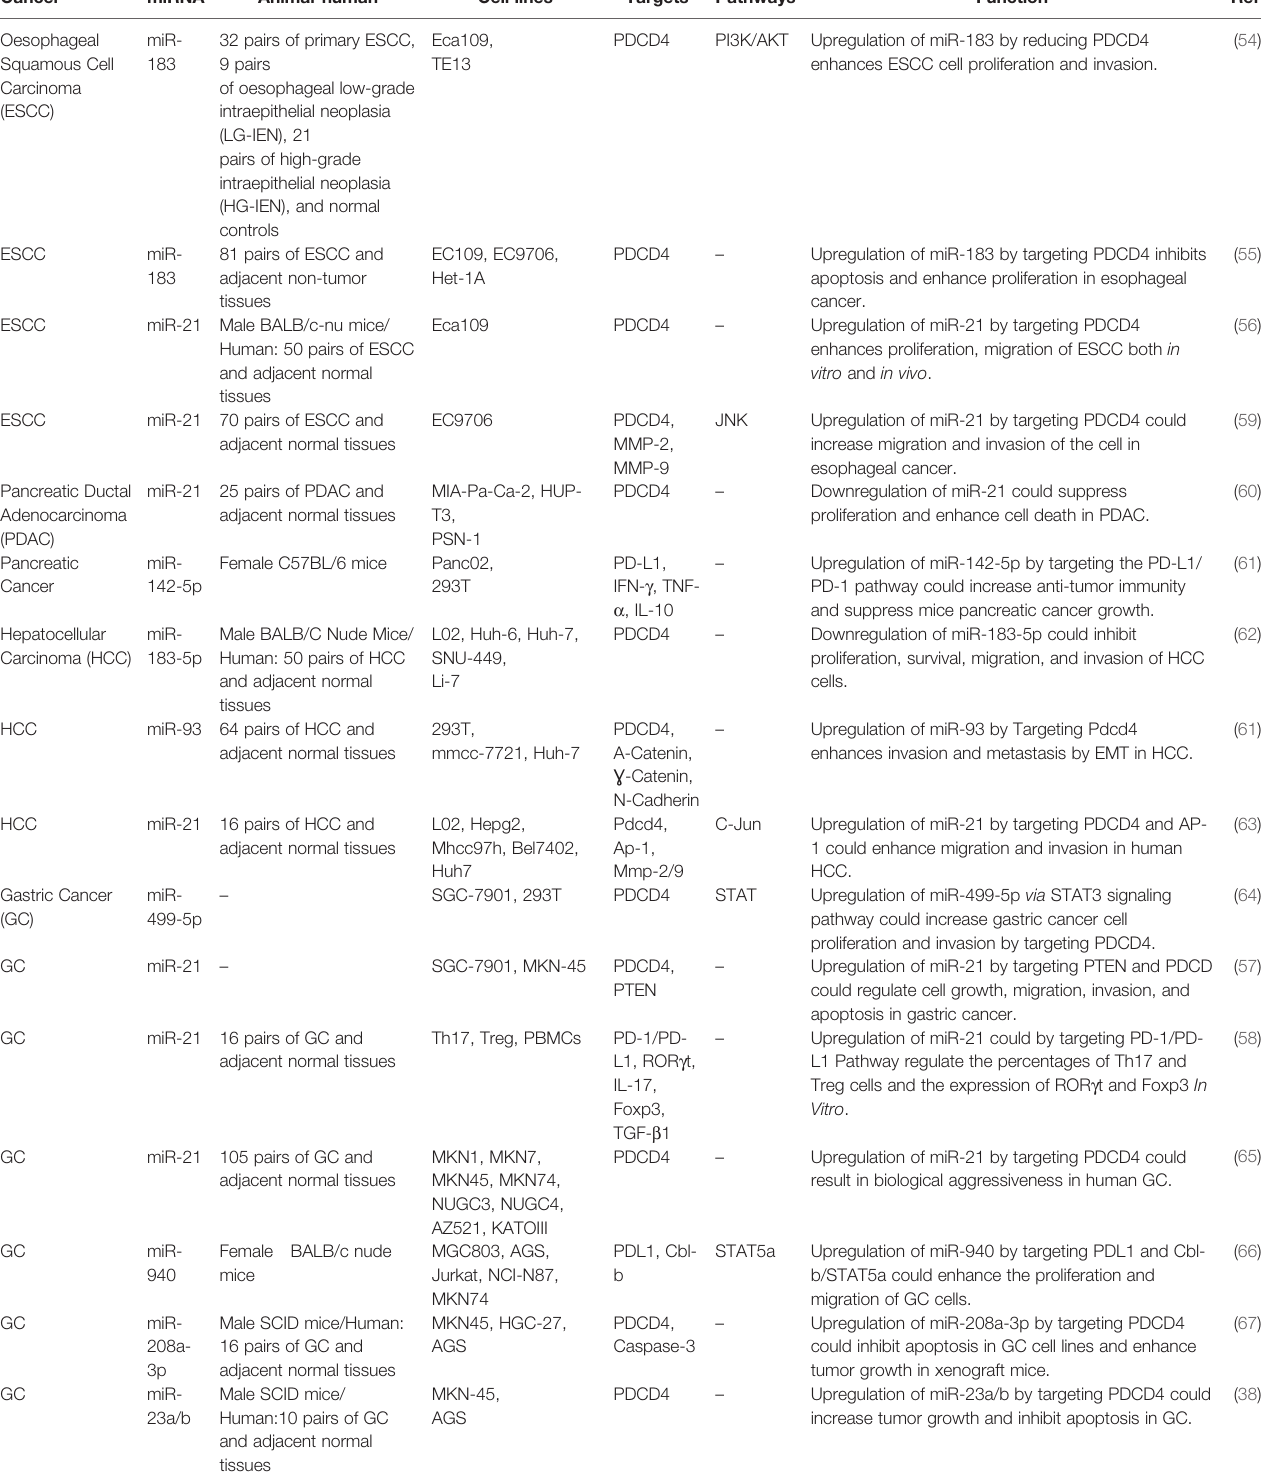
TABLE 5 | Interaction between miRNAs and PDCD in gastrointestinal cancers. Cancer